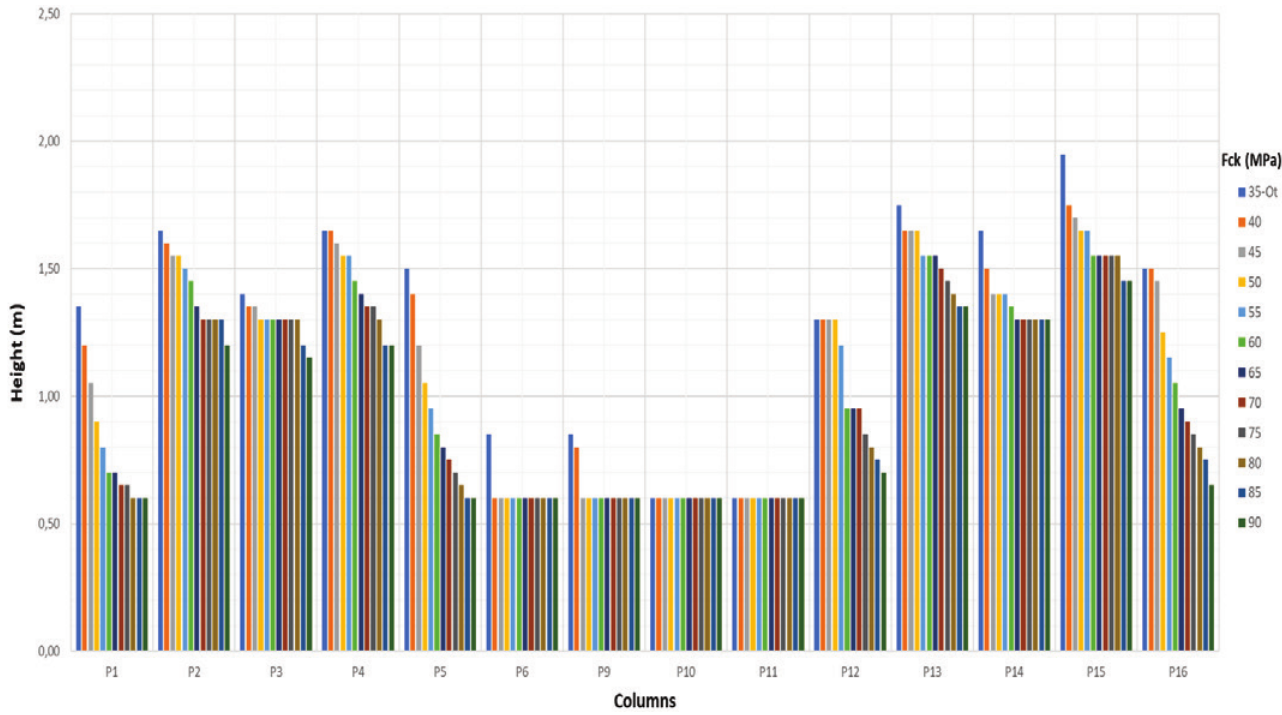
Figure 6 Height variations of the columns’